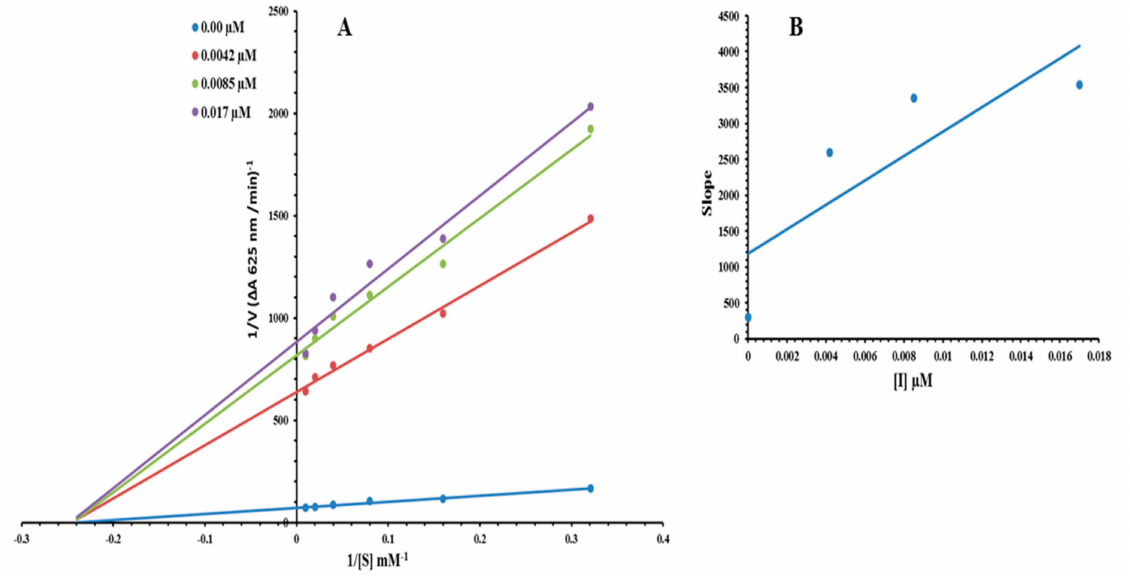
Figure 3. Lineweaver-Burk plots for inhibition of urease in the presence of compound 3j . ( A ) Concentrations of 3j were 0.00, 0.0042, 0.0085, and 0.017 µ M. ( B ) The insets represent the plot of the slope or the vertical versus inhibitor 3j concentrations to determine inhibition constants. The lines were drawn using linear least squares